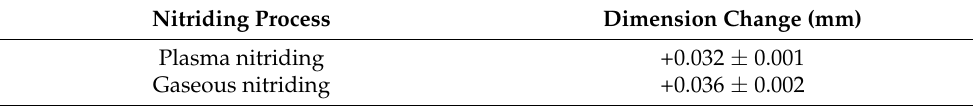
Table 2. Changes in sample dimensions after nitriding processes.